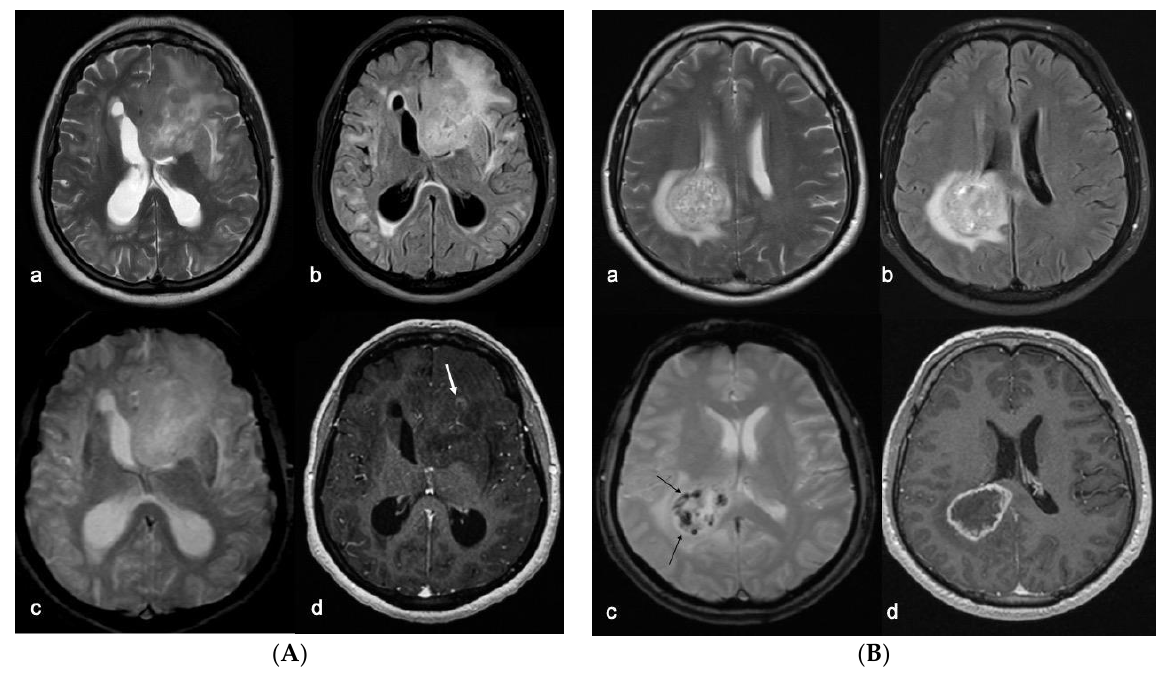
Figure 4. ( A ) Left frontal GBM with typical imaging findings of MGMT methylated (inactive) tumors. Despite the size of the lesion and its heterogeneous signal on the T2w fast spin echo ( a ) and T2w FLAIR images ( b ), there are no calcifications or intratumoral bleedings on the T2*w gradient echo images ( c ) and only a small irregular area of contrast enhancement appreciable after i.v. administration of contrast medium on the T1w pulse sequences (arrow in ( d )). ( B ) Right GBM with typical imaging findings of the MGMT not-methylated subtype. The lesion is deeply localized in the fronto-parietal periventricular zone, with a heterogeneous signal on the T2w fast spin echo ( a ) and T2w FLAIR images ( b ), calcifications and/or bleedings on the T2*w gradient echo images (arrows in ( c )), with a typical ring enhancement after i.v. administration of contrast medium on the T1w pulse sequences ( d ) that delimits a central area of intratumoral necrosis.